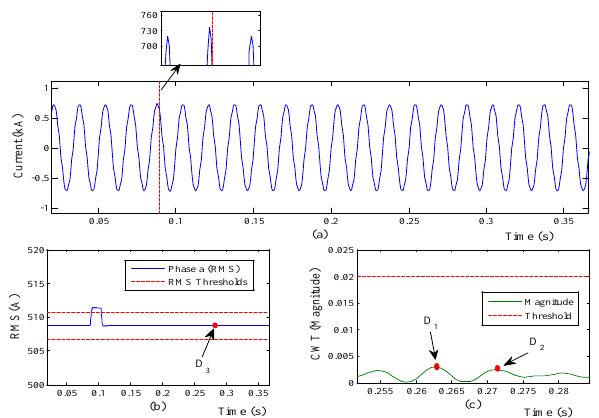
Figure 8. Permanent Fault event in (13-Bus) is detected and classified, ( a )